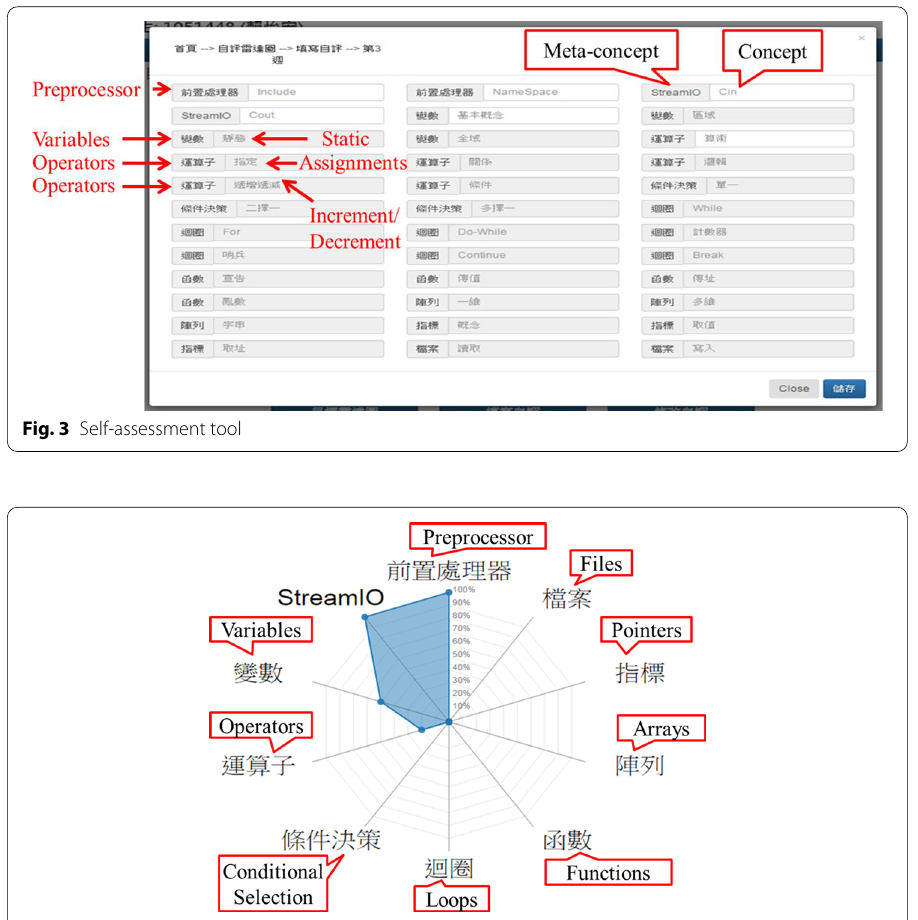
Fig. 4 An OLM for representing students’ mastery levels of